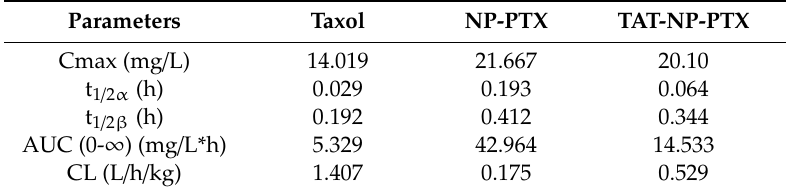
Figure 4. ( A ) Concentration of PTX in Institute of Cancer Research (ICR) mice plasma after tail intravenous injection of three PTX formulations at the dose of 7.5 mg/kg ( n = 3); ( B ) Quantification of PTX accumulated in tumor tissues and major organs 8 h after injection. Dates are expressed as mean ± standard deviation (SD) ( n = 3, * p < 0.05, ** p < 0.01). Table 2. Pharmacokinetics after tail vein injection of three PTX formulations at a dose of 7.5 mg/kg in ICR mice ( n = 3).